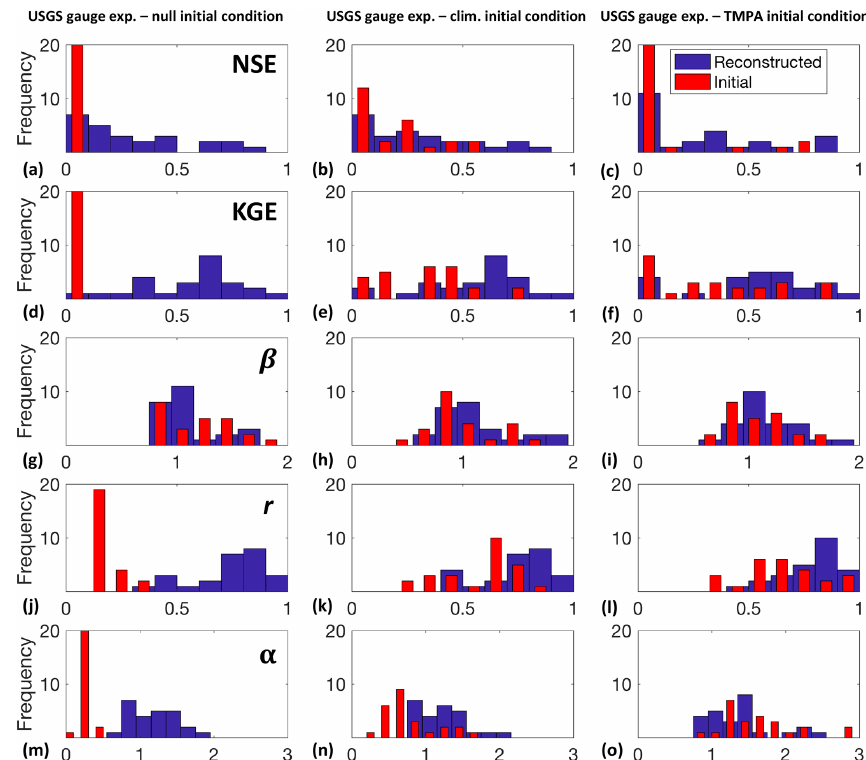
Figure 8. Distributions of NSE and KGE values for the three synthetic experiments with varied initial conditions of runoff and USGS observations as the synthetic truth. The ordering is the same as that in Fig.